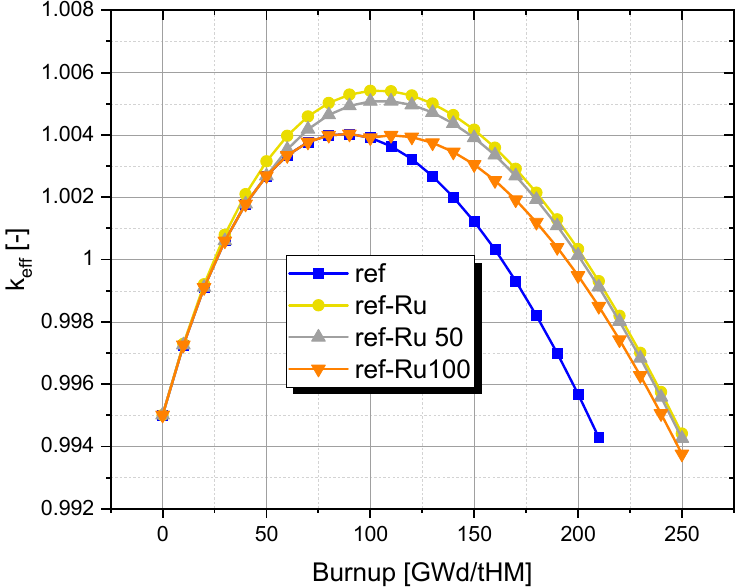
Figure 5. Effect on criticality caused by different initiation of the clean-up system on the example of Ruthenium separation, based on a simulation using 10 GWd/tHM steps and a 5% reduction of the Ruthenium content at each step.